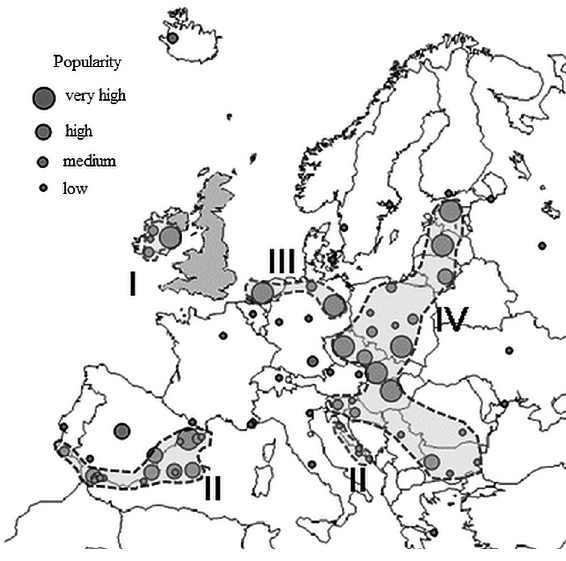
Fig. 9. stag weekend thematic regions Note: I – British Isles, II – Mediterranean Region, III – Red Light Districts’ Region, Iv – Central and East Euro- pean Region based on the analyzed